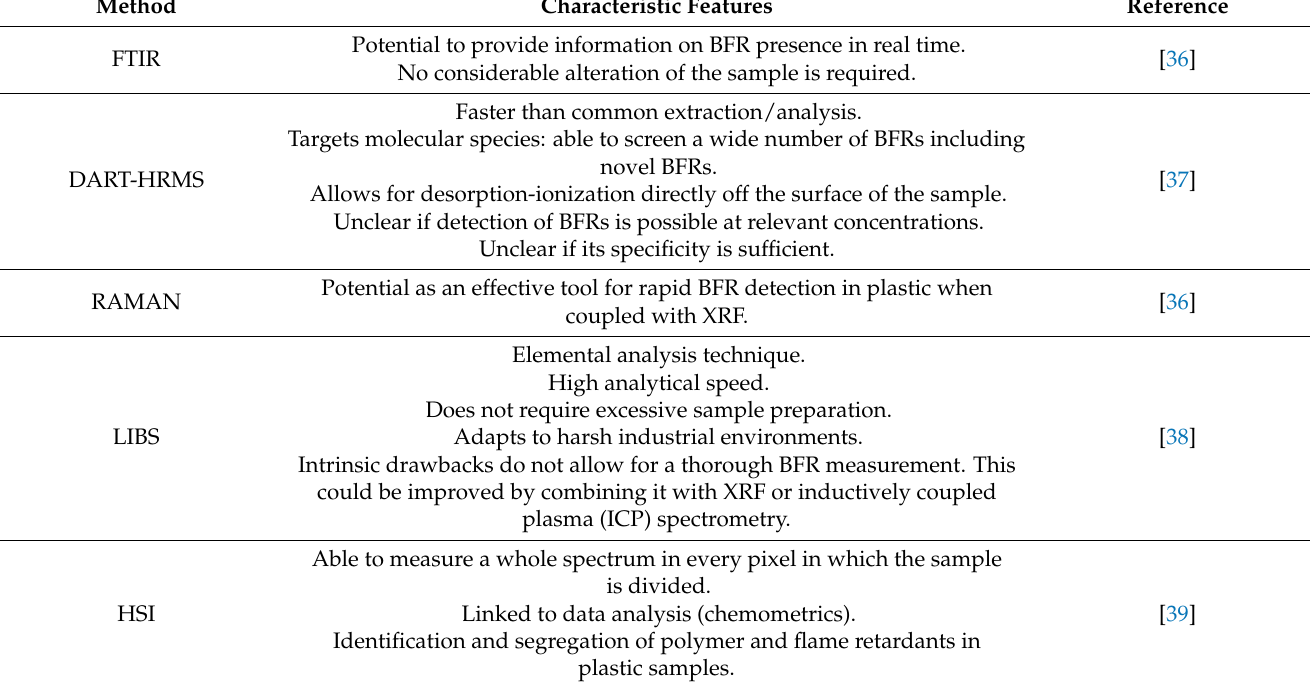
Table 3. Methods for sorting WEEE plastics according to their BFR contents. Method Characteristic Features